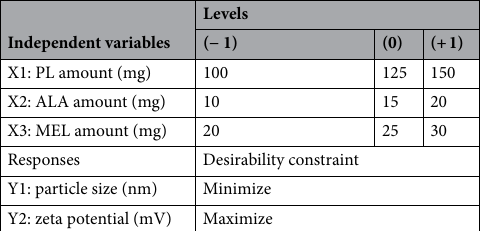
Table 1. Independent variables’ levels and responses’ constraint employed in the design of FLV- PL-ALA-MEL